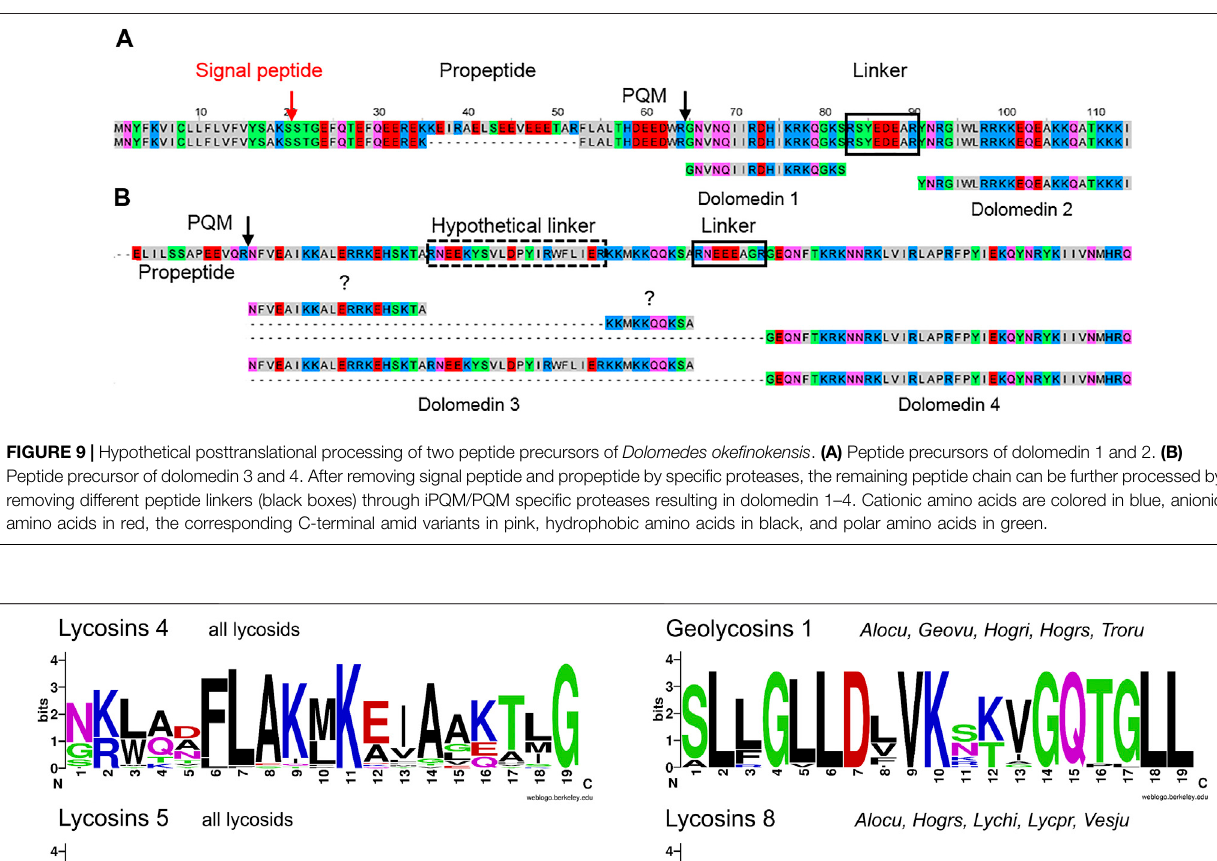
Frontiers in Molecular Biosciences |